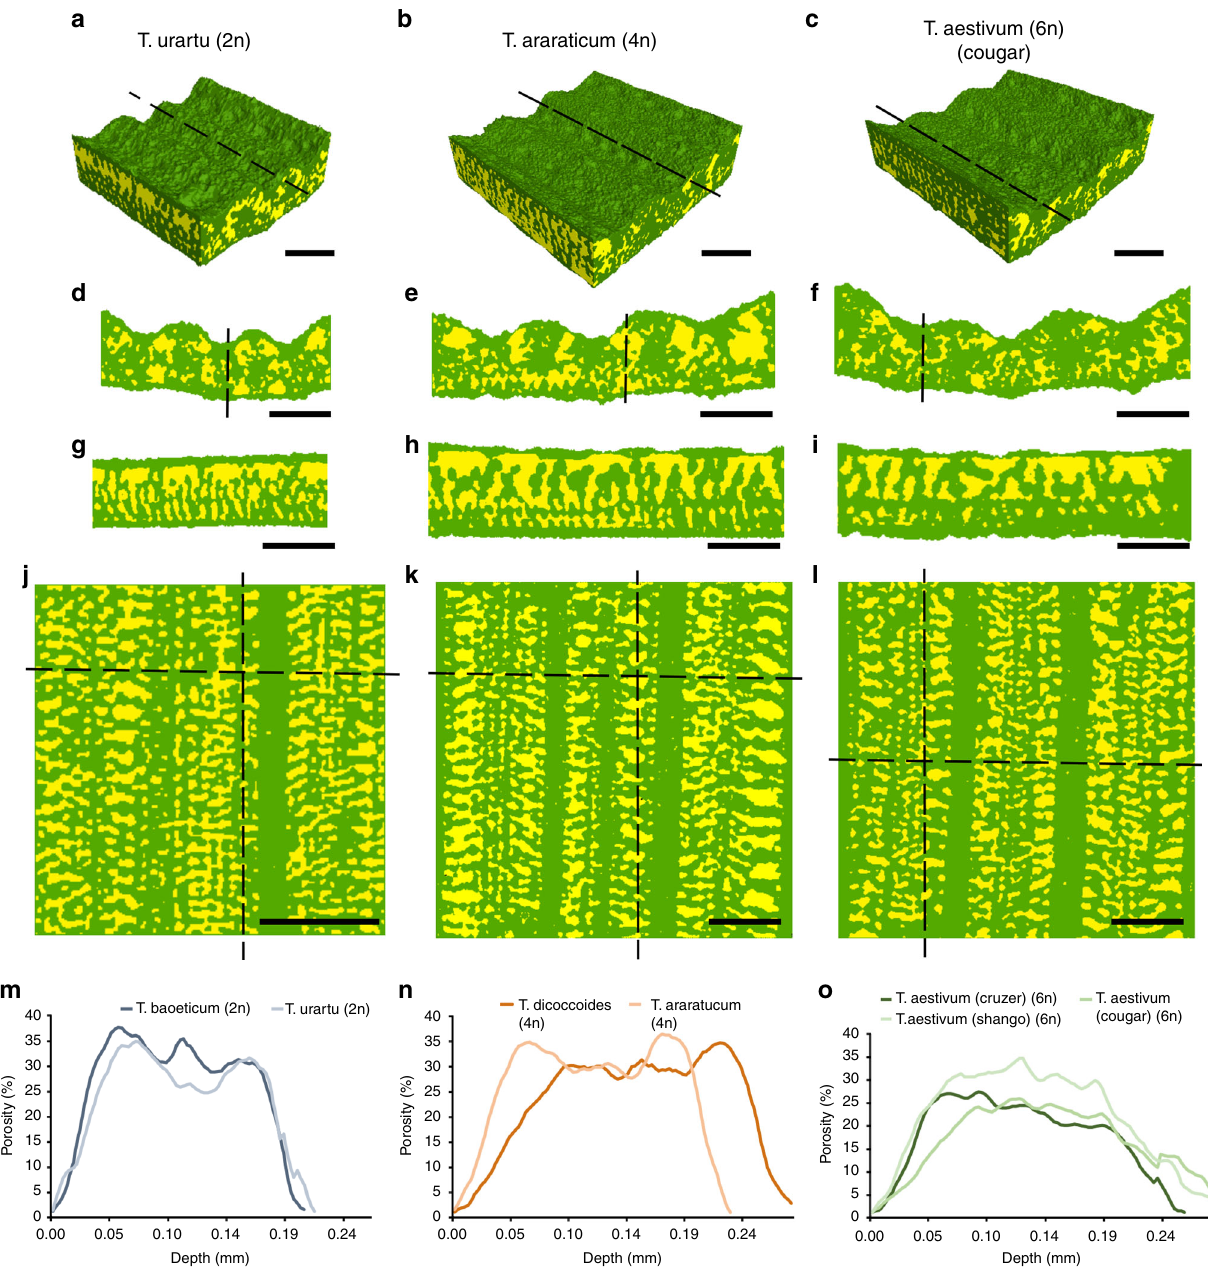
Fig. 2 MicroCT imaging reveals variation in wheat leaf airspace with ploidy. Sample leaf images of Triticum urartu (2n), T. araraticum (4n) and T. aestivum cv Cougar (6n) in 3D renderings of tissue blocks ( a – c ), transverse sections ( d – f ), longitudinal sections ( g – i ), and paradermal sections ( j – l ), with solid tissue in green and airspace in yellow. Mesophyll porosity (%) ( m – o ) is plotted along leaf depth from adaxial to abaxial surfaces in the diploid ( m ), tetraploid ( n ), and hexaploid ( o ) lines, as indicated. T. baoeticum – dark blue; T. urartu – light blue; T. dicoccoides – dark orange; T. araraticum – light orange; T. aestivum (Crusoe) – dark green; T. aestivum (Cougar) – mid-green; T. aestivum (Shango) – light green. For clarity, only mean values of 6 replicated samples are presented in panels m – o . Lines in a – c indicate plane of section in g – i , respectively, also indicated by vertical lines in j – l . Horizontal lines in j – l indicate plane of section for d – f , respectively. Image resolution = 2.75 µ m. Scale bars a – l = 200 µ not simply in 2D sections but across the 3D depth of the tissue. (Fig. 2m) with the hexaploid species showing a shallower por- Analysis of tissue porosity (i.e., airspace volume as a proportion osity gradient (Fig. 2o) and, generally, a lower maximal porosity of total tissue volume) from the adaxial (top) to the abaxial value than that observed in the diploid species. The tetraploid (bottom) surface of leaves revealed similarities and differences in species showed intermediate patterns of porosity throughout the the amount and distribution of airspace. All species displayed a leaf depth (Fig. 2n). Overall, our analysis of structural parameters pattern of increasing porosity further away from the epidermis, across wheat leaves of different ploidy suggests that while the with a plateau of relatively high porosity across the middle part basic pattern of airspace and tissue distribution within the leaf of the leaf (Fig. 2m – o). The rate of increase of porosity with has been conserved during the evolution of hexaploid wheat distance into the leaf was greatest for the diploid species from diploid and tetraploid wild relatives, there has been